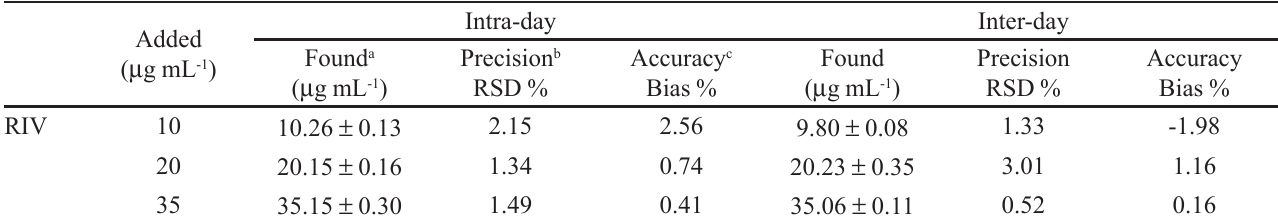
TABLE V - Precision and accuracy of the developed method Added